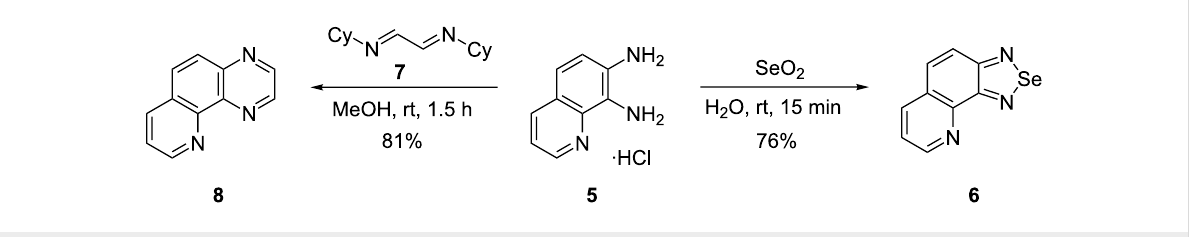
Scheme 2: Application of hydrochloride 5 in the syntheses of nitrogen heterocycles.